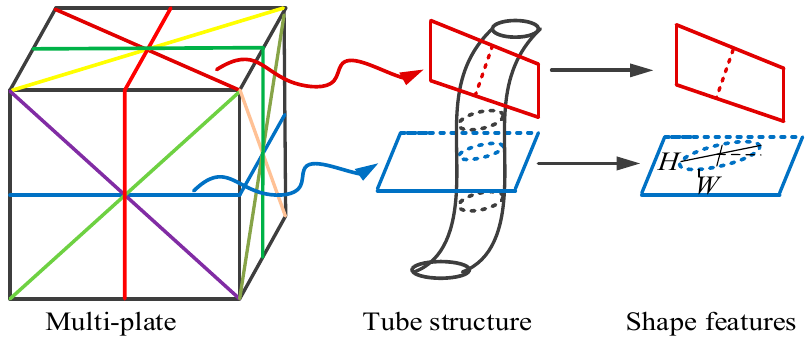
Figure 6. A multiple section model.